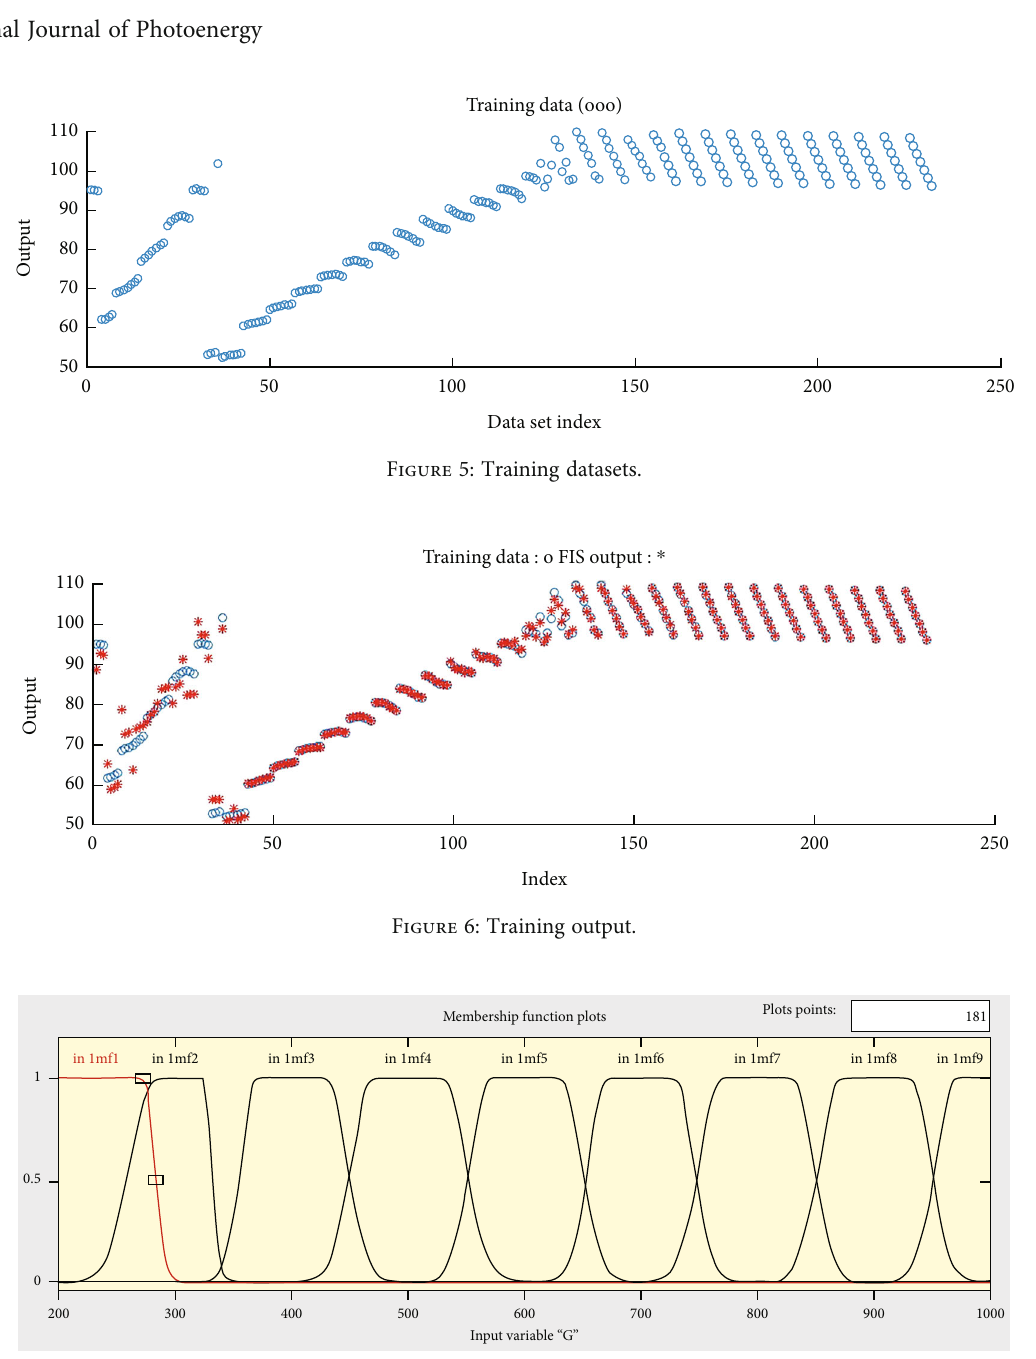
Figure 7: Membership functions of input G